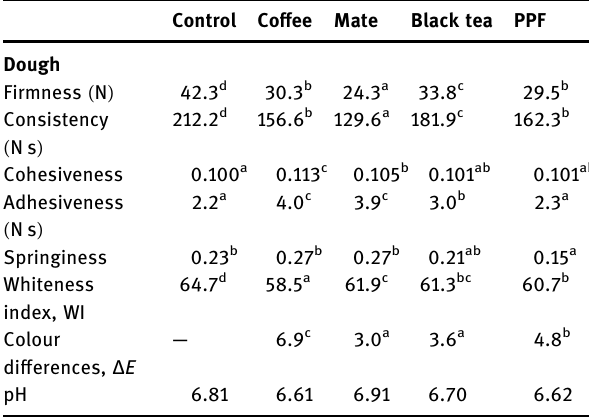
Table 4: Physical characteristics of gluten - free dough prepared from 25:25:25:25 rice fl our:cassava starch:maize starch:chickpea